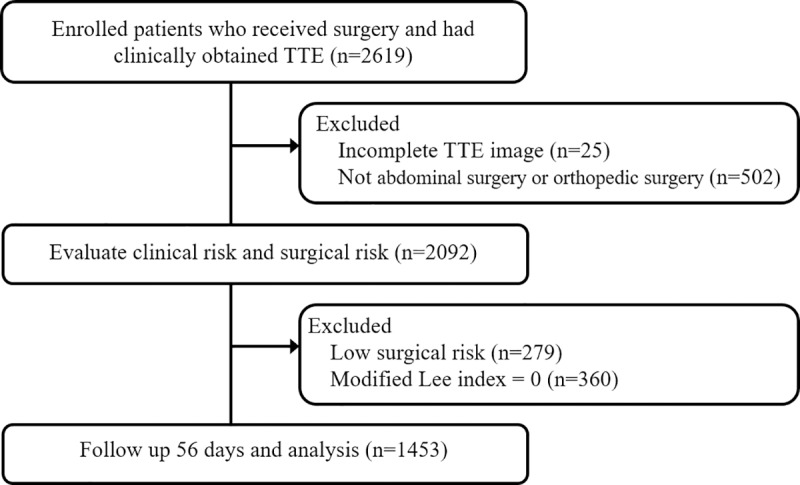
Consort diagram for patient inclusion.